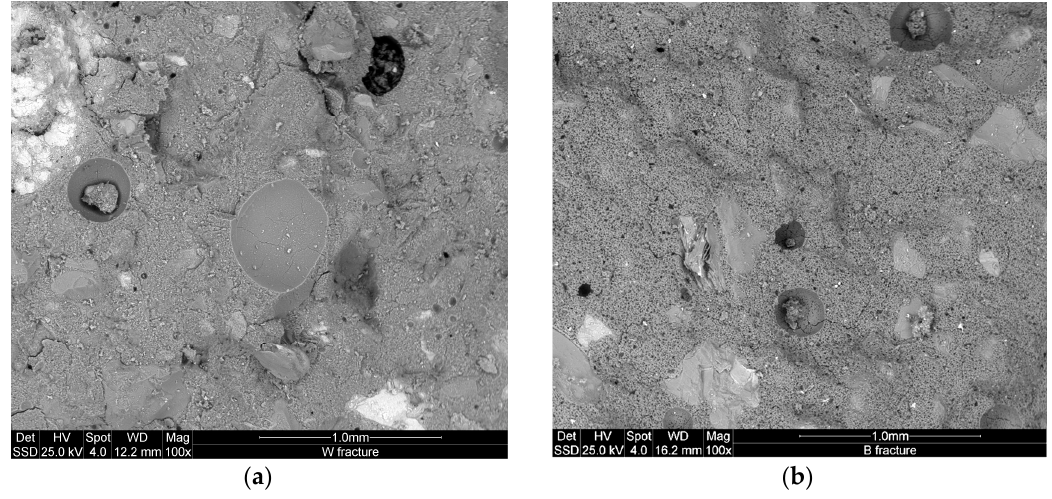
Figure 10. ESEMmicrostructure of fracture surface at low enlargements of the specimens with: ( a ) white ABS; ( b ) black ABS.